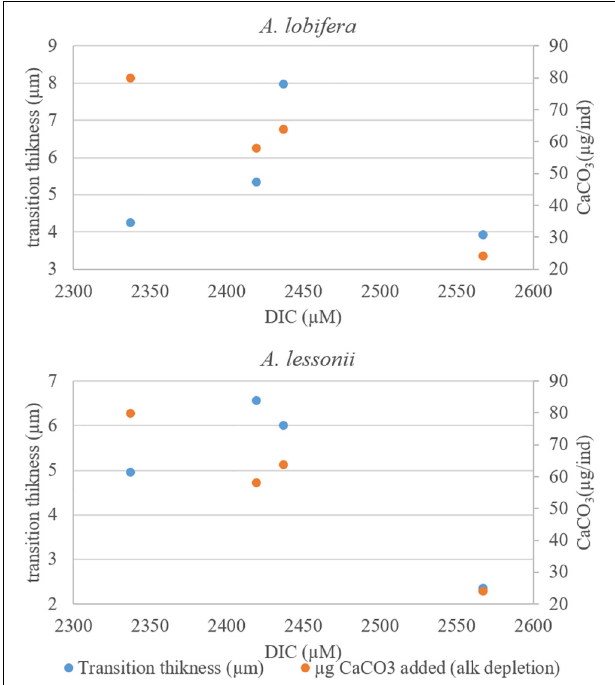
FIGURE 9 | The transition zone thickness (based on 135 Ba) as a function of DIC. The two intermediate DIC treatments yielded a thicker transition zone. There are no simple relations between the thickness of the transitions zones and the total shell growth (second Y axis) of these